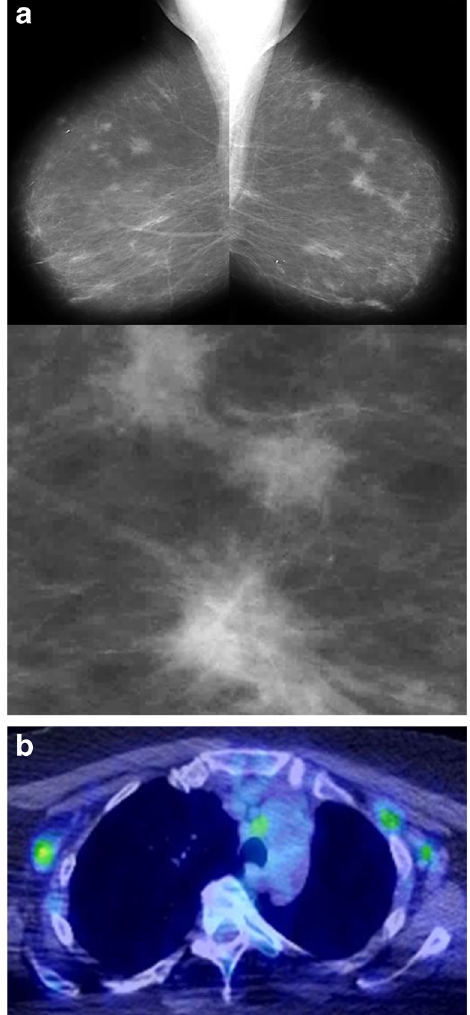
Fig. 9 Sarcoidosis. A 72-year-old woman had a prior skin biopsy show- ing sarcoidosis. a Bilateral mediolateral-oblique views and magnification view show multiple spiculated masses in both breasts. These had been unchanged for 5 years. b Positron emission tomography showed multiple areas of increased uptake in mediastinal and axillary lymph nodes. Histopathological examination of left breast ultrasound-guided biopsy specimens showed non-caseating granulomas consistent with sarcoidosis (not